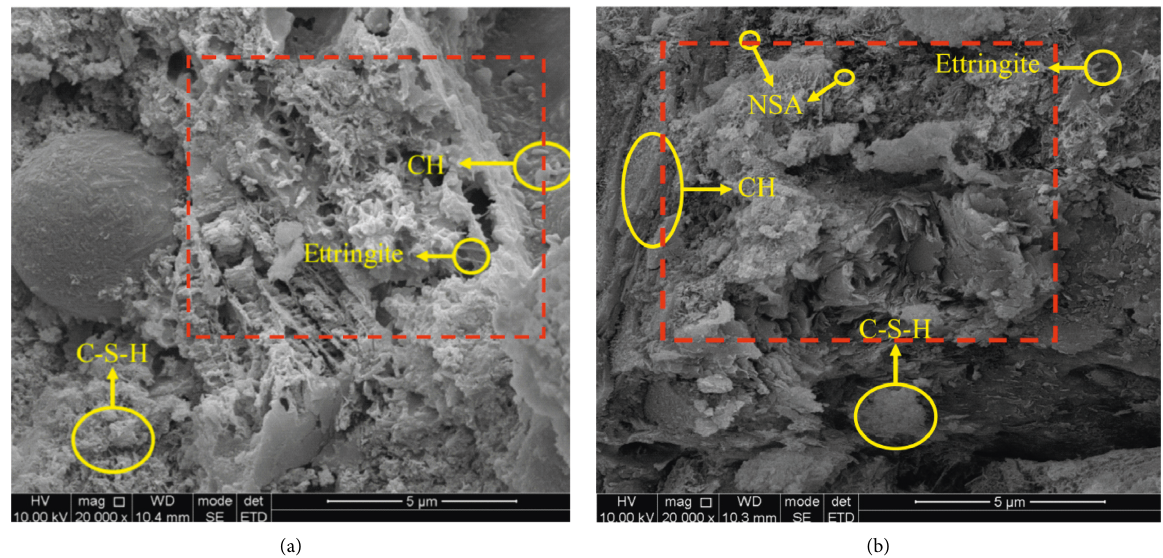
Figure 6: SEM images of (a) AFC-2 (without NSAP) and (b) AFC-7 (with NSAP) sample cross section.